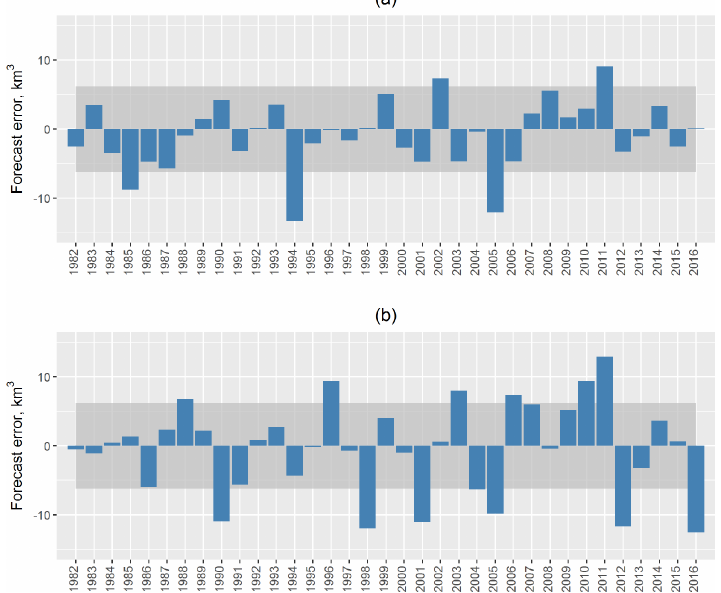
Figure 4. Errors of the ESP-based (a) and operational (b) forecasts of the April–June volume of water inflow into the Cheboksary Reservoir. (Solid lines present boundaries of the acceptable error, which equalled ± 0.674 σ W , where σ W = 9.61km 3 is the standard deviation of the observed inflow